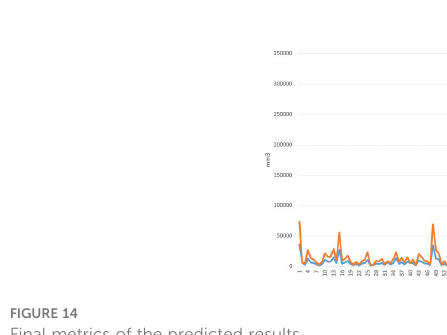
FIGURE 14 Final metrics of the predicted